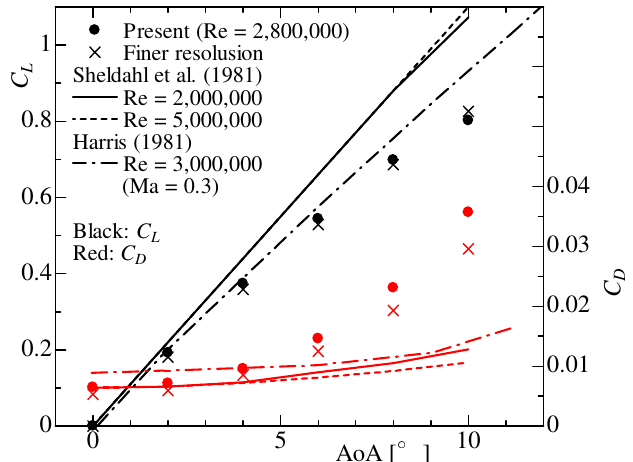
Figure 3. Aerodynamic performance of the NACA 0012